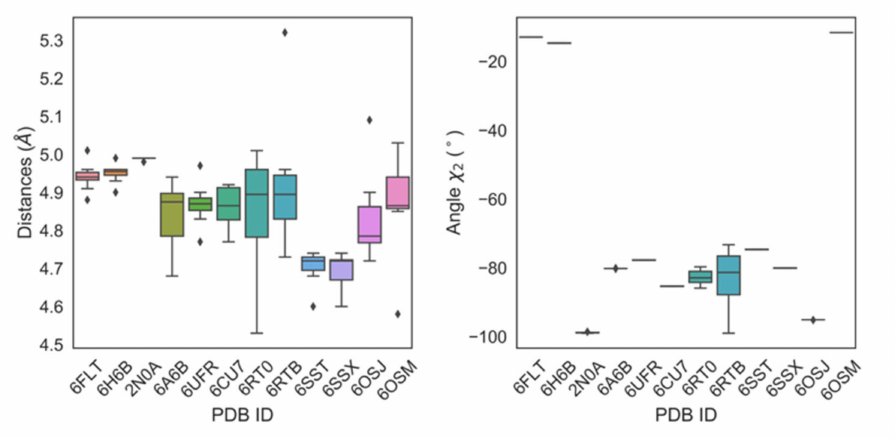
Figure 8. Structural features of fibrillated wt α S proteins. Boxplots showing the distribution of values for ring-to-ring distances (left) and χ 2 dihedral angles (right) for fibrillated α S proteins in the PDB for